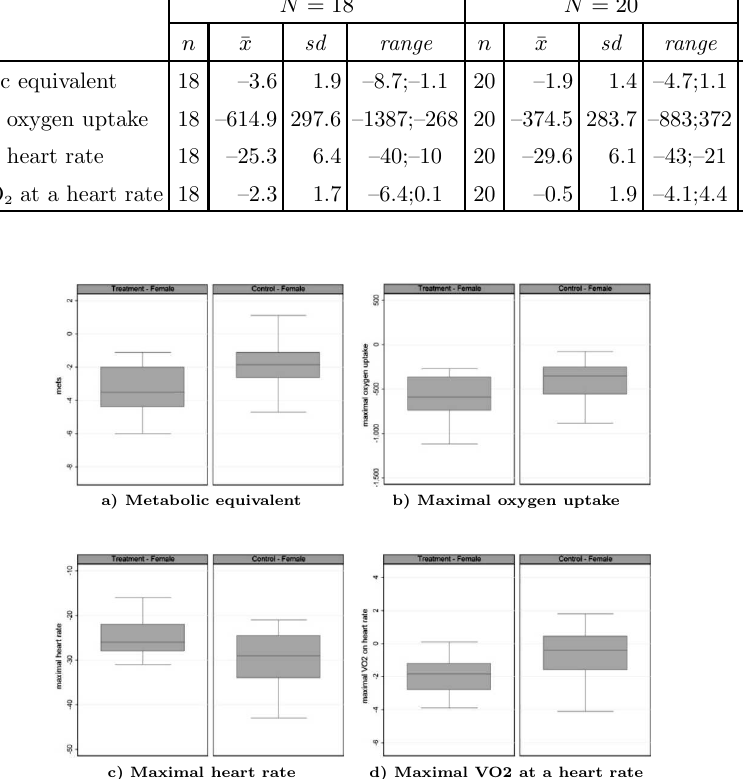
Figure 2. Box plots for four cardiovascular parameters for the treatment and the control group for the female